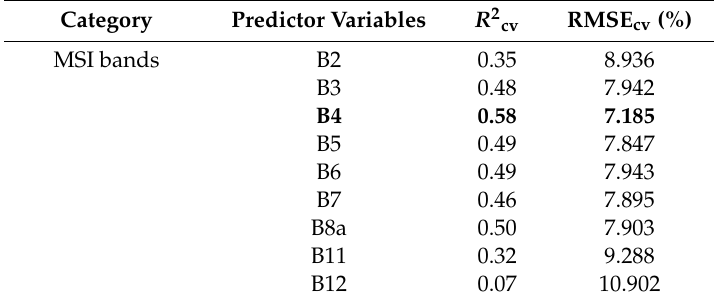
Figure 4. Correlation matrix for CRC and predictor variables including MSI bands, indices and textural features. The Sentinel-2 MSI bands are represented as B2, B3, ... , B12. The mean textural feature are represented as B2_mean, B3_mean, ... , B8_mean. The length on the minor axis of the ellipse indicates the strength of the Pearson’s correlation coefficient between each pair variables, while the colors of the ellipse indicate whether the correlation is positive or negative. Table 3. Performance of MSI bands, crop residue indices (CRIs) and textural features on estimating CRC. The best-performing variables for each category are highlighted in